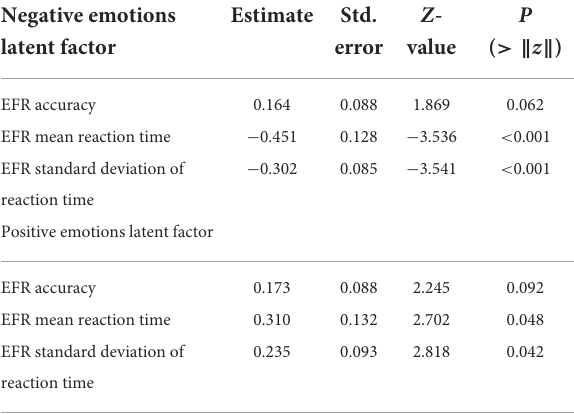
TABLE 4 Normalized estimates for latent factors estimated with confirmatory factor analysis summarizing emotional face recognition task performance for positive and negative